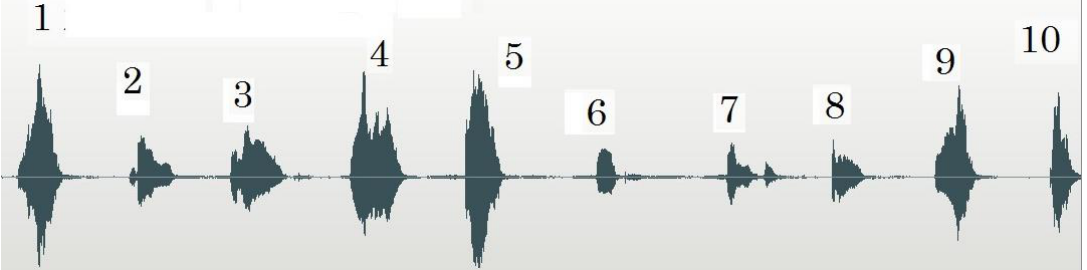
Fig. 3: A typical sound recording while pronouncing one, two, three etc.